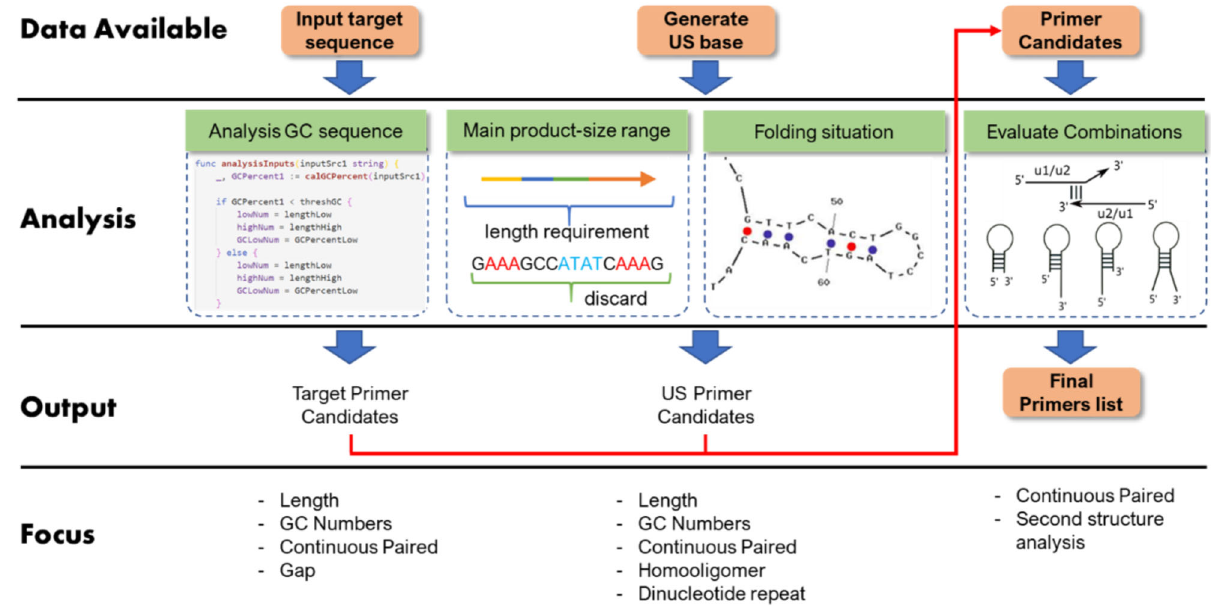
Fig. 2 Flow chart of primers design software. Flow chart of primers design software including (1) screening target sequences, (2) randomly designing and screening US sequences, and (3) fi ltering and outputting the fi nal primers according to the four different schemes (see details in Supplementary